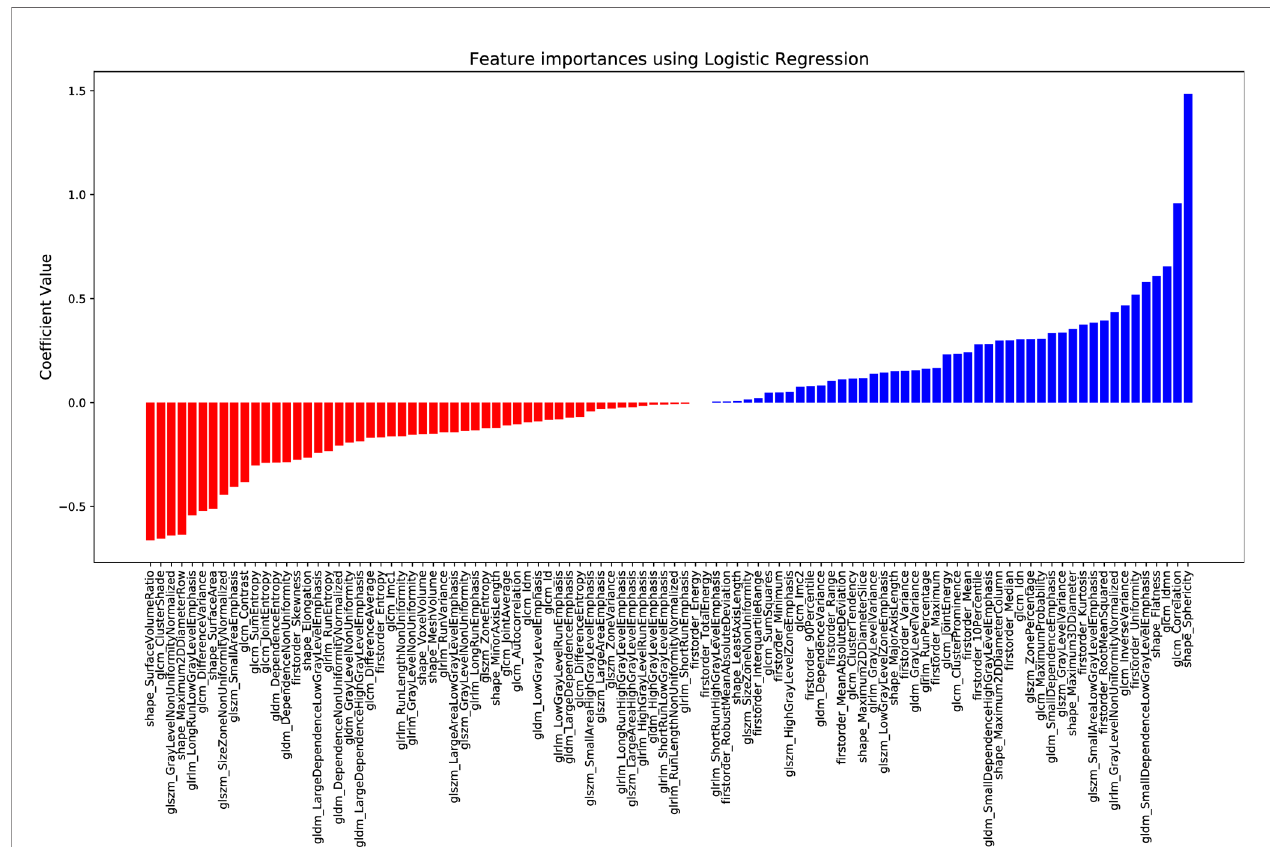
FIGURE 3 | Coef fi cient of each radiomic feature in the decision function for the proposed logistic regression